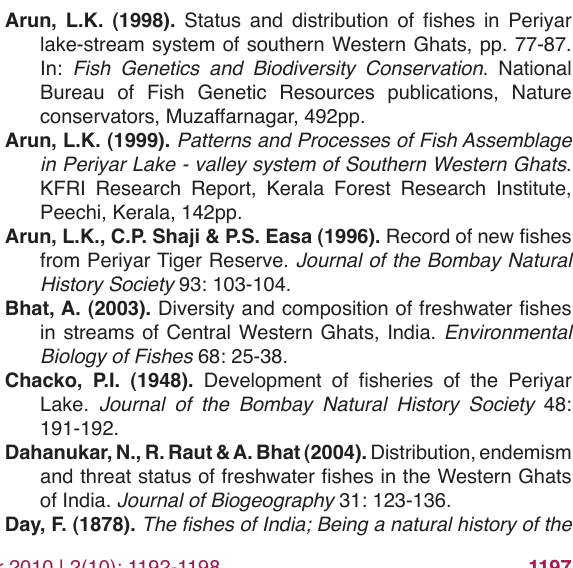
encountered in the present study while, G. periyarensis which shows great similarity in body morpho-meristics with G. mcclellandi was collected in adequate numbers. The present collection included all the 27 fishes recorded by Arun (1998) from the Periyar Lake and stream systems. Majority (45%) of the fish fauna of PTR is